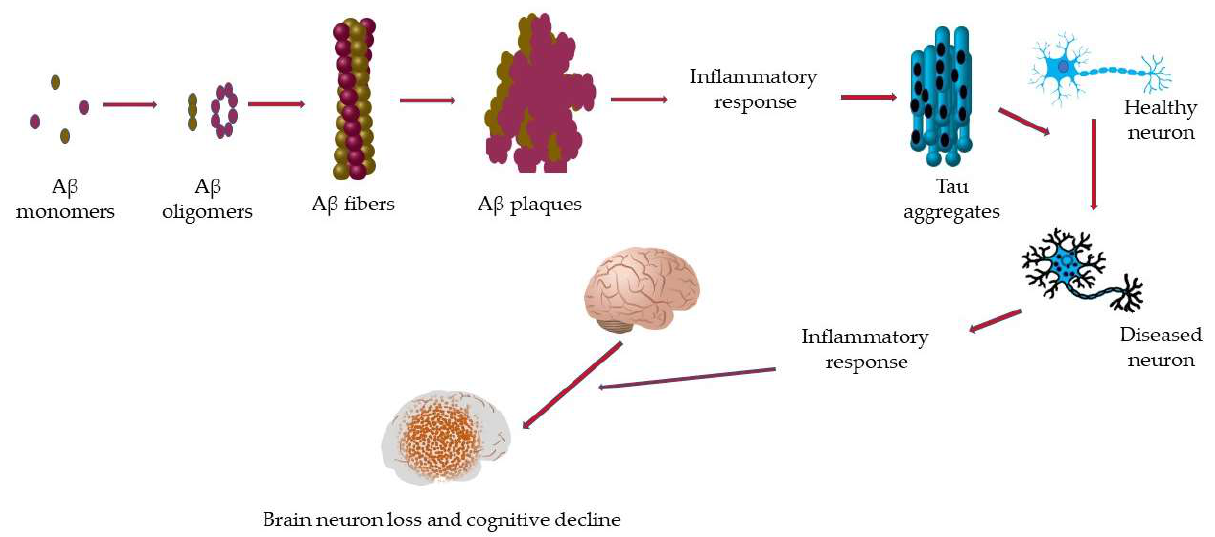
Figure 1. Path to cognitive decline in neurodegeneration. Amyloid-beta (A β ) monomers clump together to form oligomers of variant structures. Subsequently, the oligomers aggregate to form A β fibers, which misarrange to form A β plaques. Plaque formation induces an inflammatory response which includes the formation of tau aggregates leading to the conversion of healthy neurons to diseased neurons. The presence of more diseased neurons triggers another inflammatory response leading to more neuron loss and a subsequent loss in brain function as well as cognitive